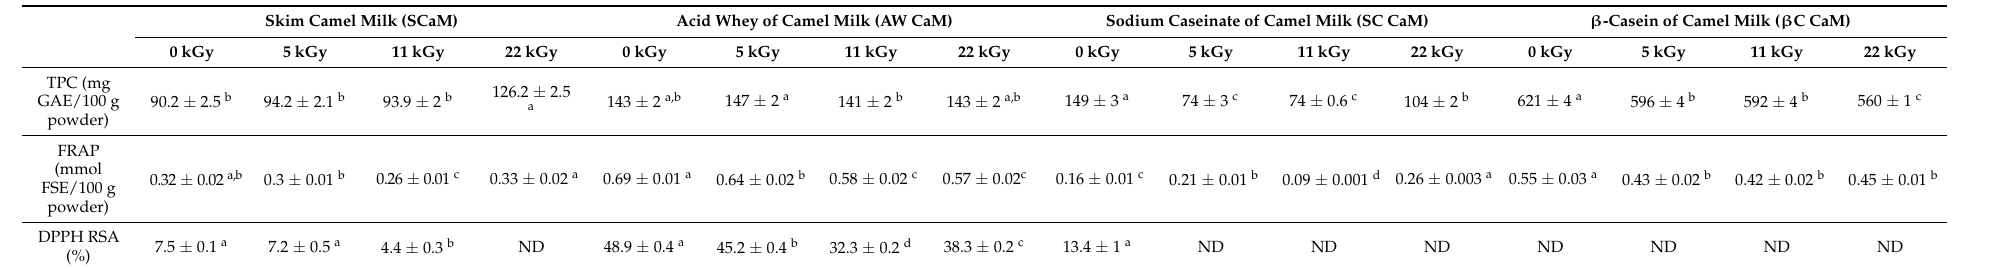
Table 2. Total phenolic contents and antioxidant activity measured by FRAP and DPPH assays, in extracts of irradiated freeze-dried camel milk fractions. The results are presented as the mean ± standard